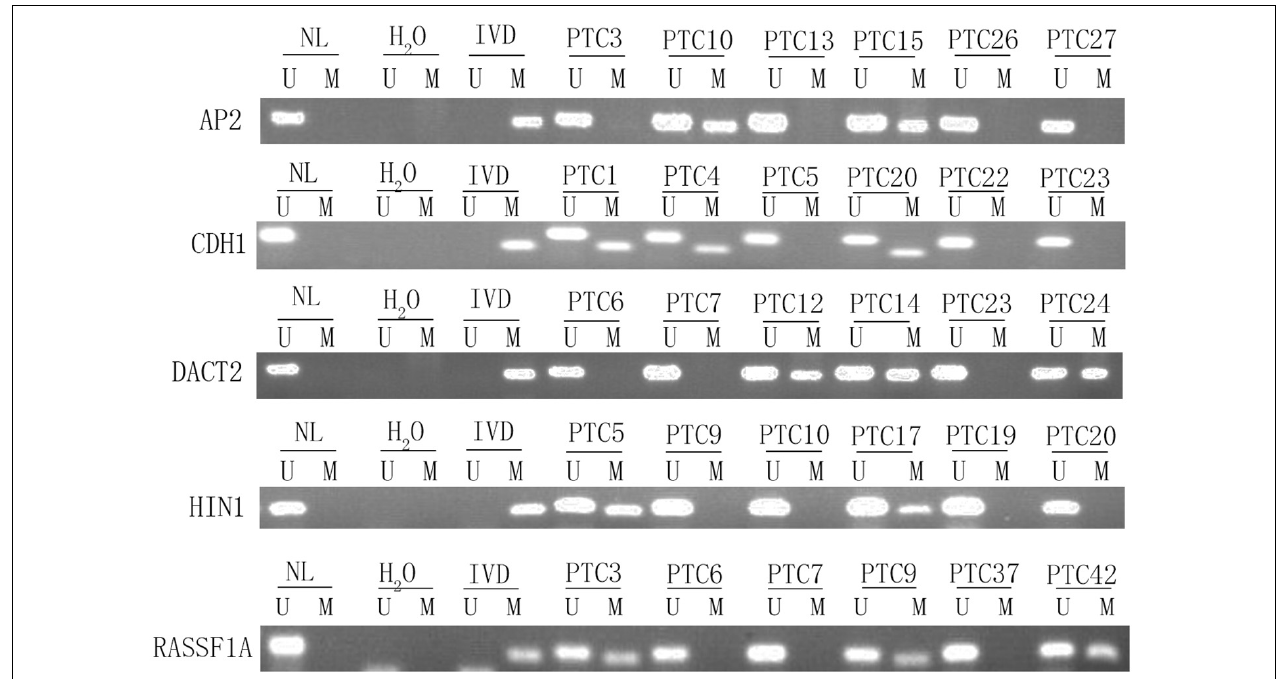
FIGURE 1 | Representative methylation results of AP2 , HIN1 , DACT2, RASSF1A, and CDH1 in thyroid cancer (discovery group). IVD, in vitro -methylated DNA (methylation control); NL, normal lymphocyte DNA (unmethylation control); H 2 O, double distilled water; U, unmethylation; M, methylation; PTC, papillary thyroid